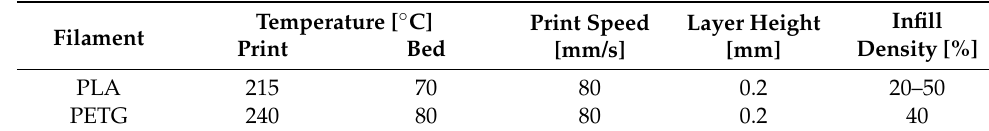
Table 3. Main print parameters for different filaments.